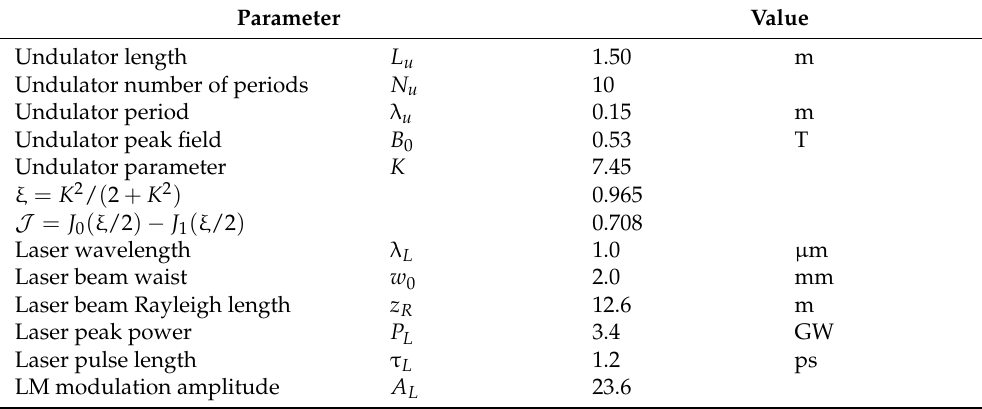
Table 1. Design parameters of the laser